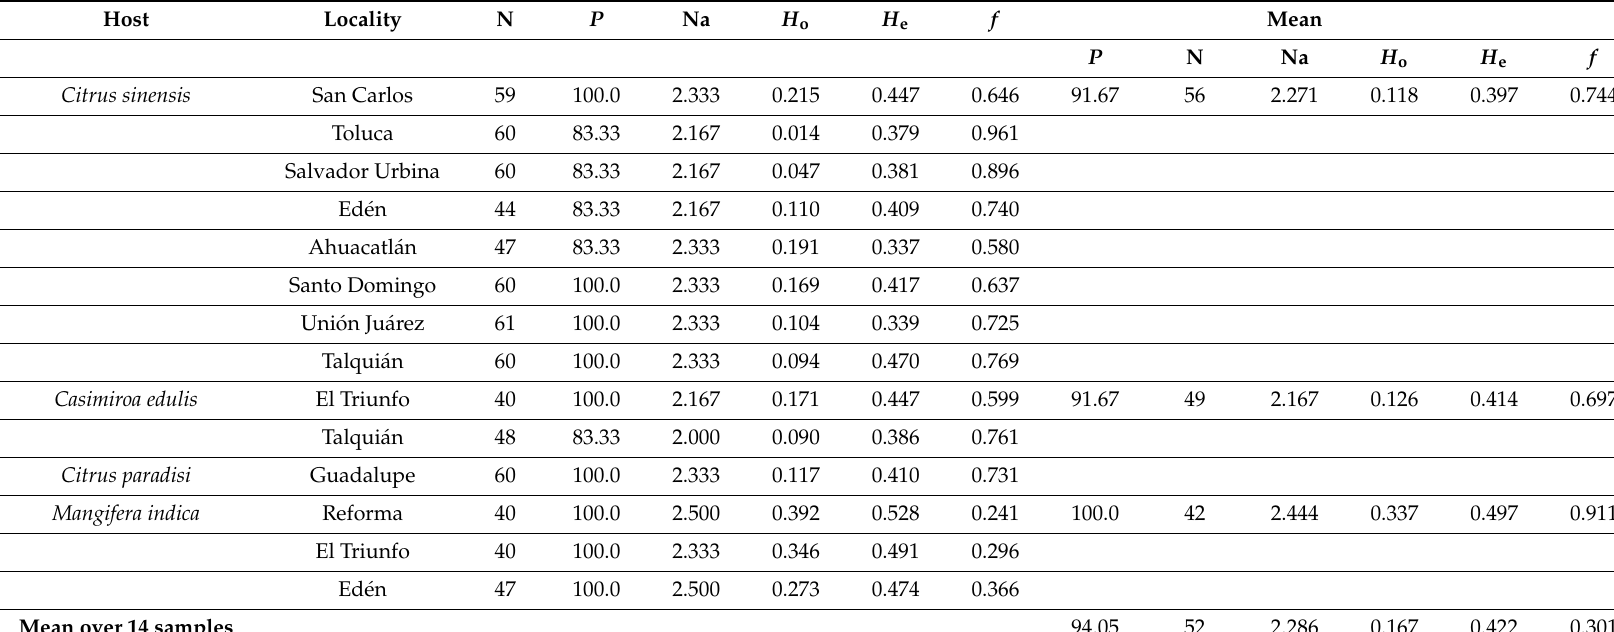
Table 5. Genetic diversity of Anastrepha ludens by host species and locality in the Soconusco region, Chiapas (Mexico). N, sample size; Na, average number of alleles; H o , observed heterozygosity; H e , unbiased heterozygosity; P , percentage of polymorphism; f fixation index as f = 1 − ( H o / H e